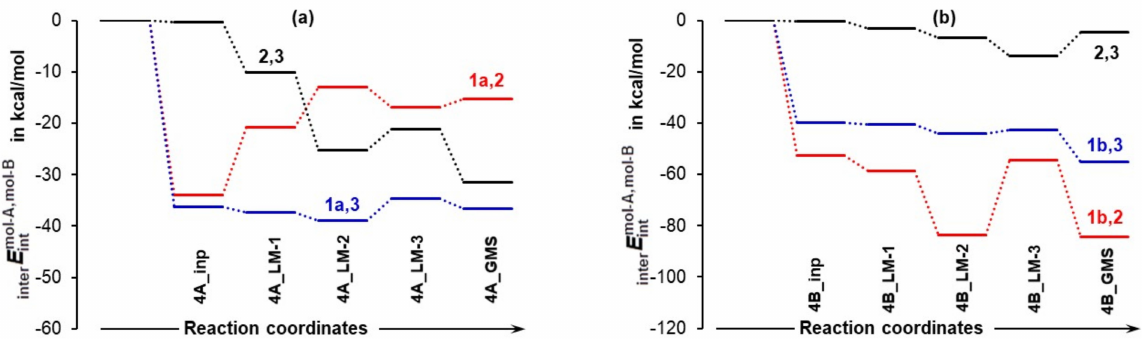
Figure 9. Relative to isolated molecules, the change in the intermolecular interaction energy between molecule-pairs involving proline and acetone 1 , 2 , proline and DMSO 1 , 3 , and acetone and DMSO 2 , 3 in the indicated 3-MCs containing the LEC of proline in part ( a ) and the HEC of proline in part ( b